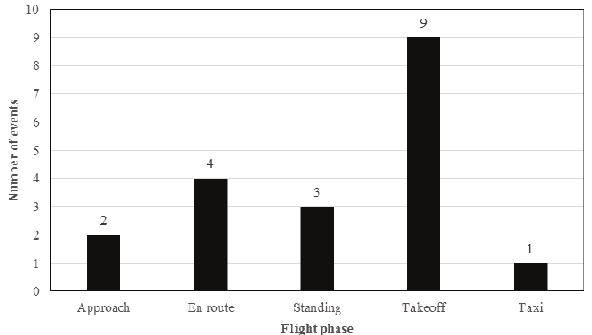
Fig. 10. Flight phases share when powerplant malfunction in the ATA 74 chapter took place